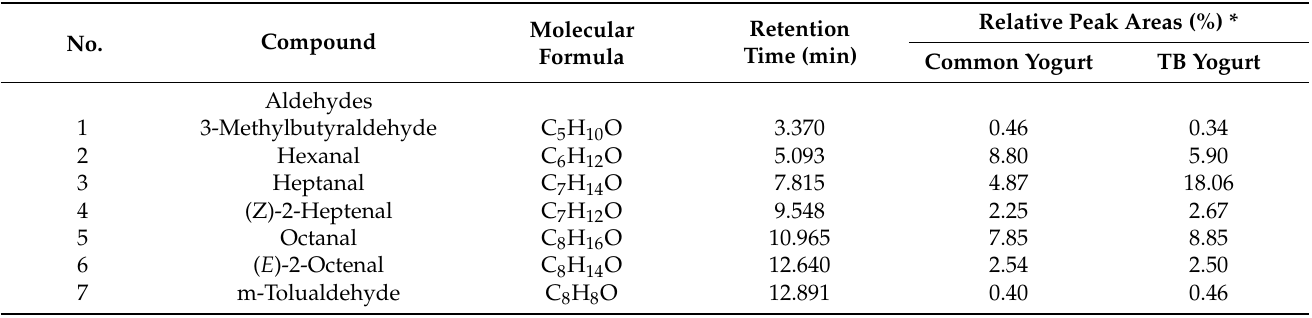
Table 3. Volatile compounds identified in yogurt samples by gas chromatography/mass spectrometry (GC/MS)